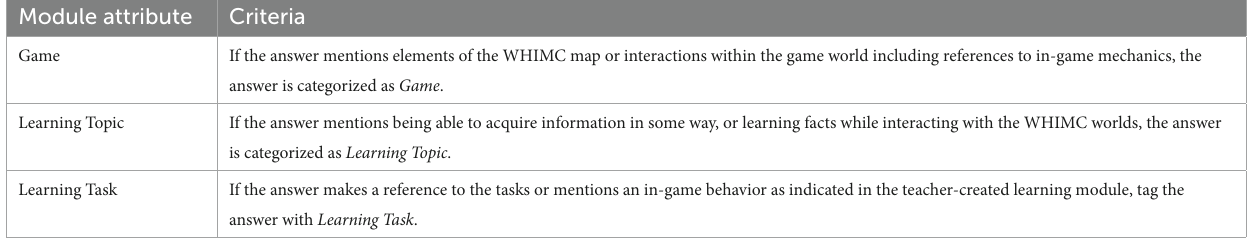
TABLE 3 Attributes of the teacher-created learning